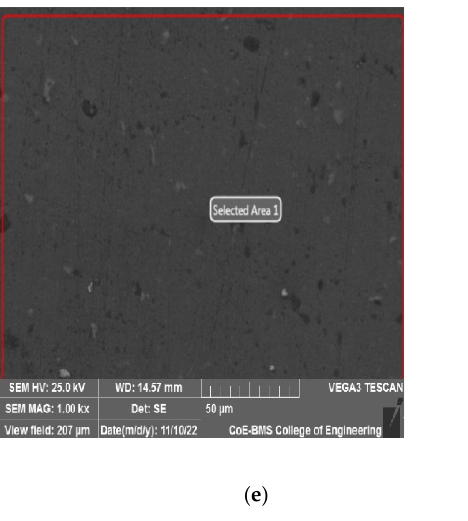
Figure 3. XRD analysis of ( a ) selected area and ( b ) EDAX of AA7075/n-B4C; ( c ) selected area and ( d ) EDAX of AA7075/n-TiO 2 ; ( e ) selected area and ( f ) EDAX of AA7075/n-Gr.